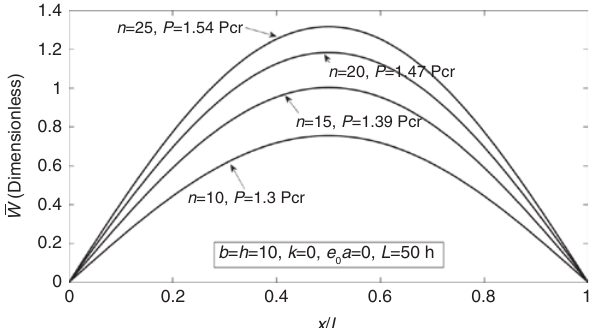
Figure 3: Effect of power law index on the buckling shape of FG nanobeams [1.3 Pcr| Pcr| ( n = 25)